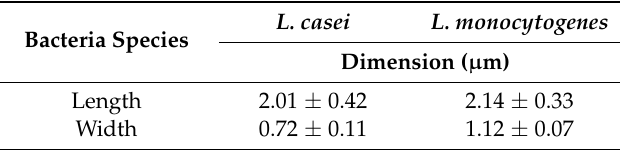
Figure 3. Two-dimensional topography AFM images of L. casei (left) and L. monocytogenes (right). Images were collected with a scan frequency of 0.7 Hz, 256 × 256 pixels, scan time 6 min. ( A , C ) and 512 × 512 pixels, scan time 13 min ( B , D ); The height scale is: 0–0.72 µ m ( A ); 0–0.88 µ m ( B ); 0–0.40 µ m ( C ) and 0–0.71 µ m ( D ). Table 1. Average cell size for L. casei and L. monocytogenes as obtained from AFM topographic data.